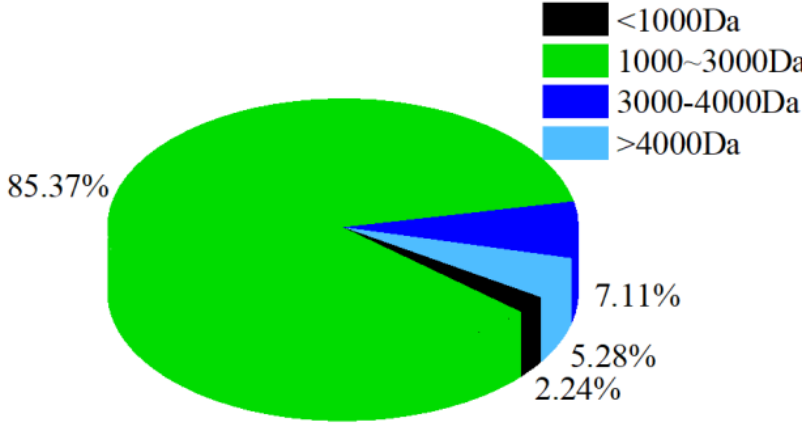
Figure 1. The molecular weight distribution of CPs.